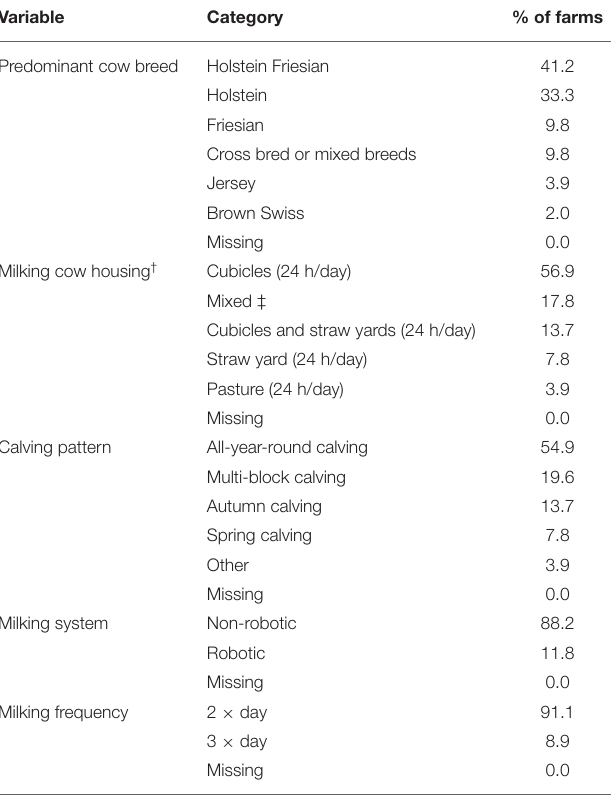
TABLE 1 | Descriptive statistics for the categorical farm management variables for the 51 cross-sectional study farms.